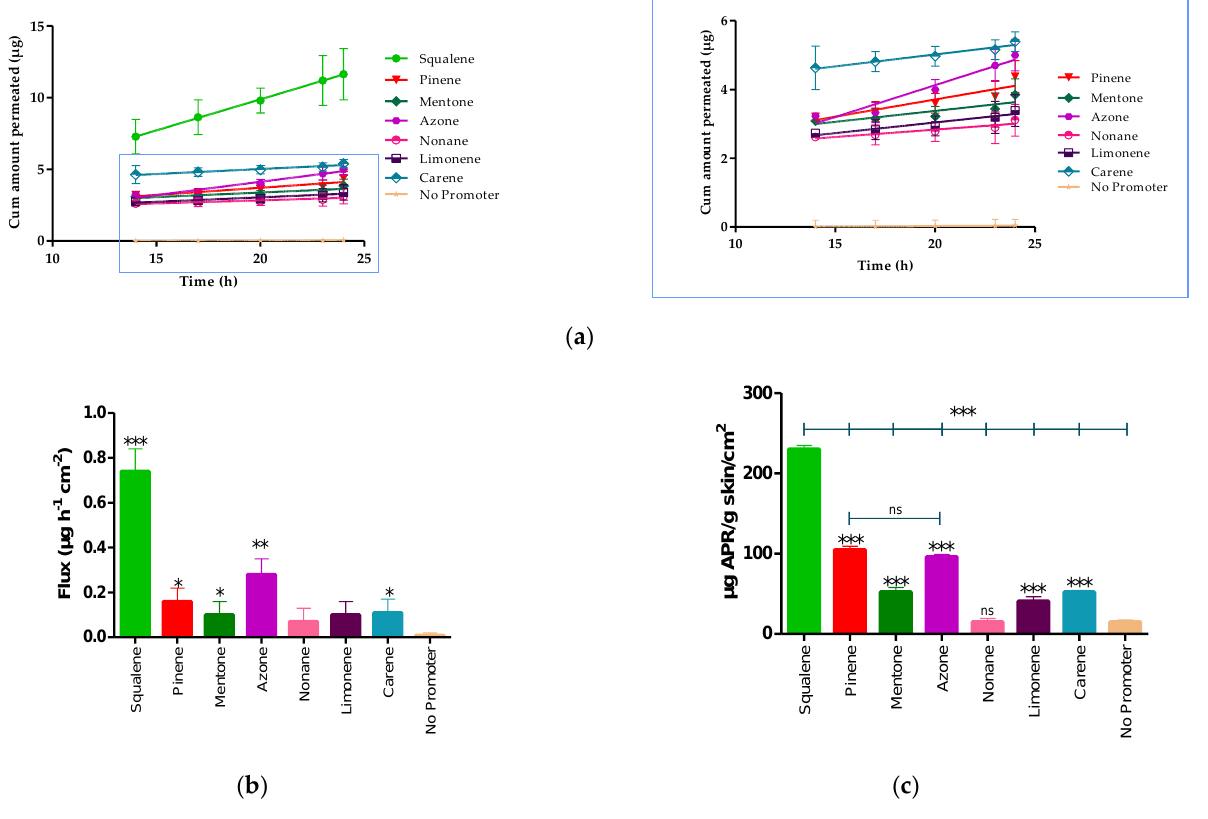
Figure 3. APR permeation profile. ( a ) Mean cumulative amount APR permeated. ( b ) APR-solutions flux. ( c ) APR retained amount in skin. Results are expressed as mean ± SD ( n = 3 ). Statistically significant difference between solutions vs. No promoter: * = p < 0.05; ** = p < 0.01; *** = p < 0.0001. The Kp is calculated from the flux dividing by the initial concentration of drug (1.5 mg/mL). After 24 h of assay, the amount of permeated drug ( Cum AP 24 h ) was 18.17 ± 3.10 µ g for squalene. Statistical differences were found between the flux